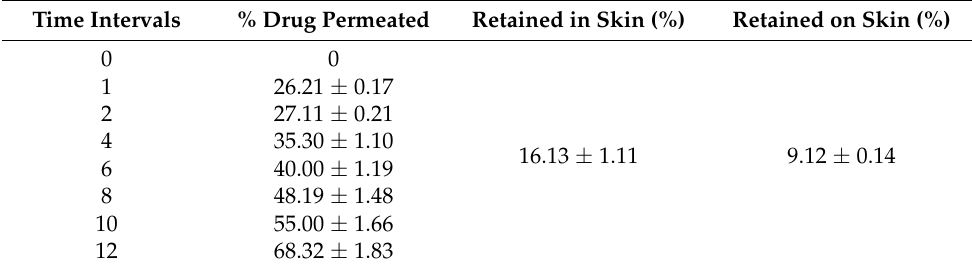
Figure 6. Ex vivo drug permeation of nanocrystal formulation. Table 5. % Drug permeated, drug retention in skin and drug retained on skin.